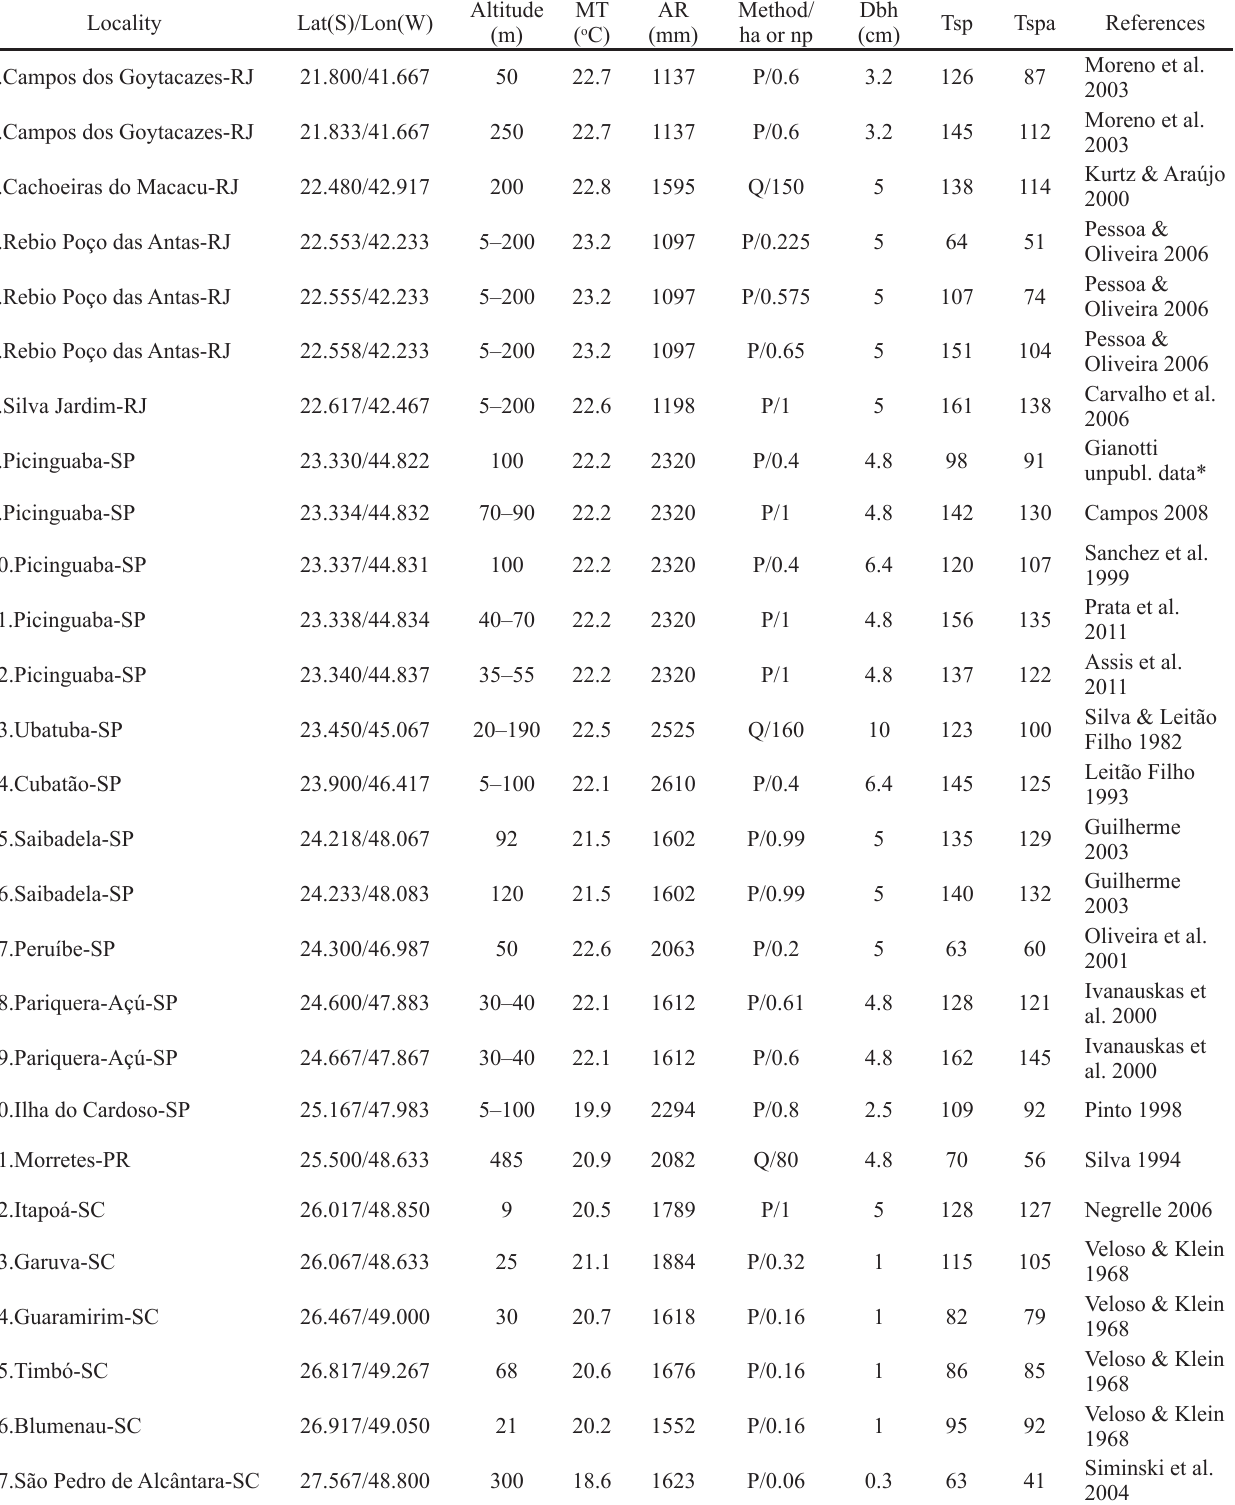
Table 1 – Floristic surveys conducted in the Atlantic Ombrophilous Dense Forest and used in our analysis. Geographical coordinates are shown in decimal degrees, altitude in meters, Mean Annual Temperature (MT) in degrees Celsius, Annual Rainfall (AR) in millimeters, Methods used in the survey (P – plots; Q – Point-Centered Quarter method) / sampled area in hectare for plots (ha) or number of points (np) for Point-Centered Quarter method, Inclusion criteria (Dbh – diameter at breast high), Total number of species in the area (Tsp), Total number of species used in the analyses (Tspa) and respective authors. * unpublished data presented in Lacerda